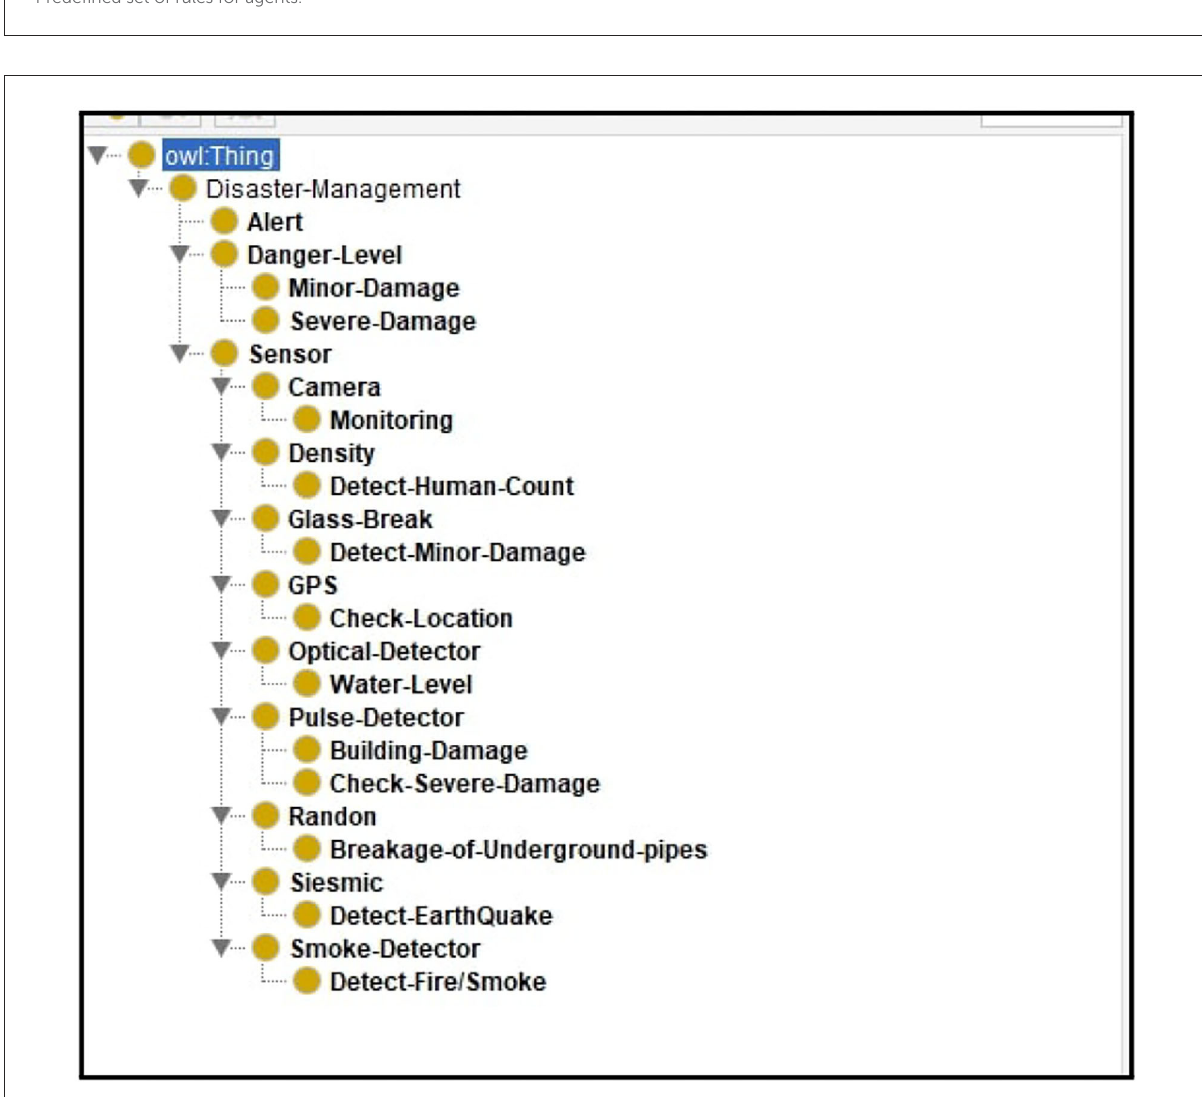
FIGURE5 Class-Hierarchy of disaster management